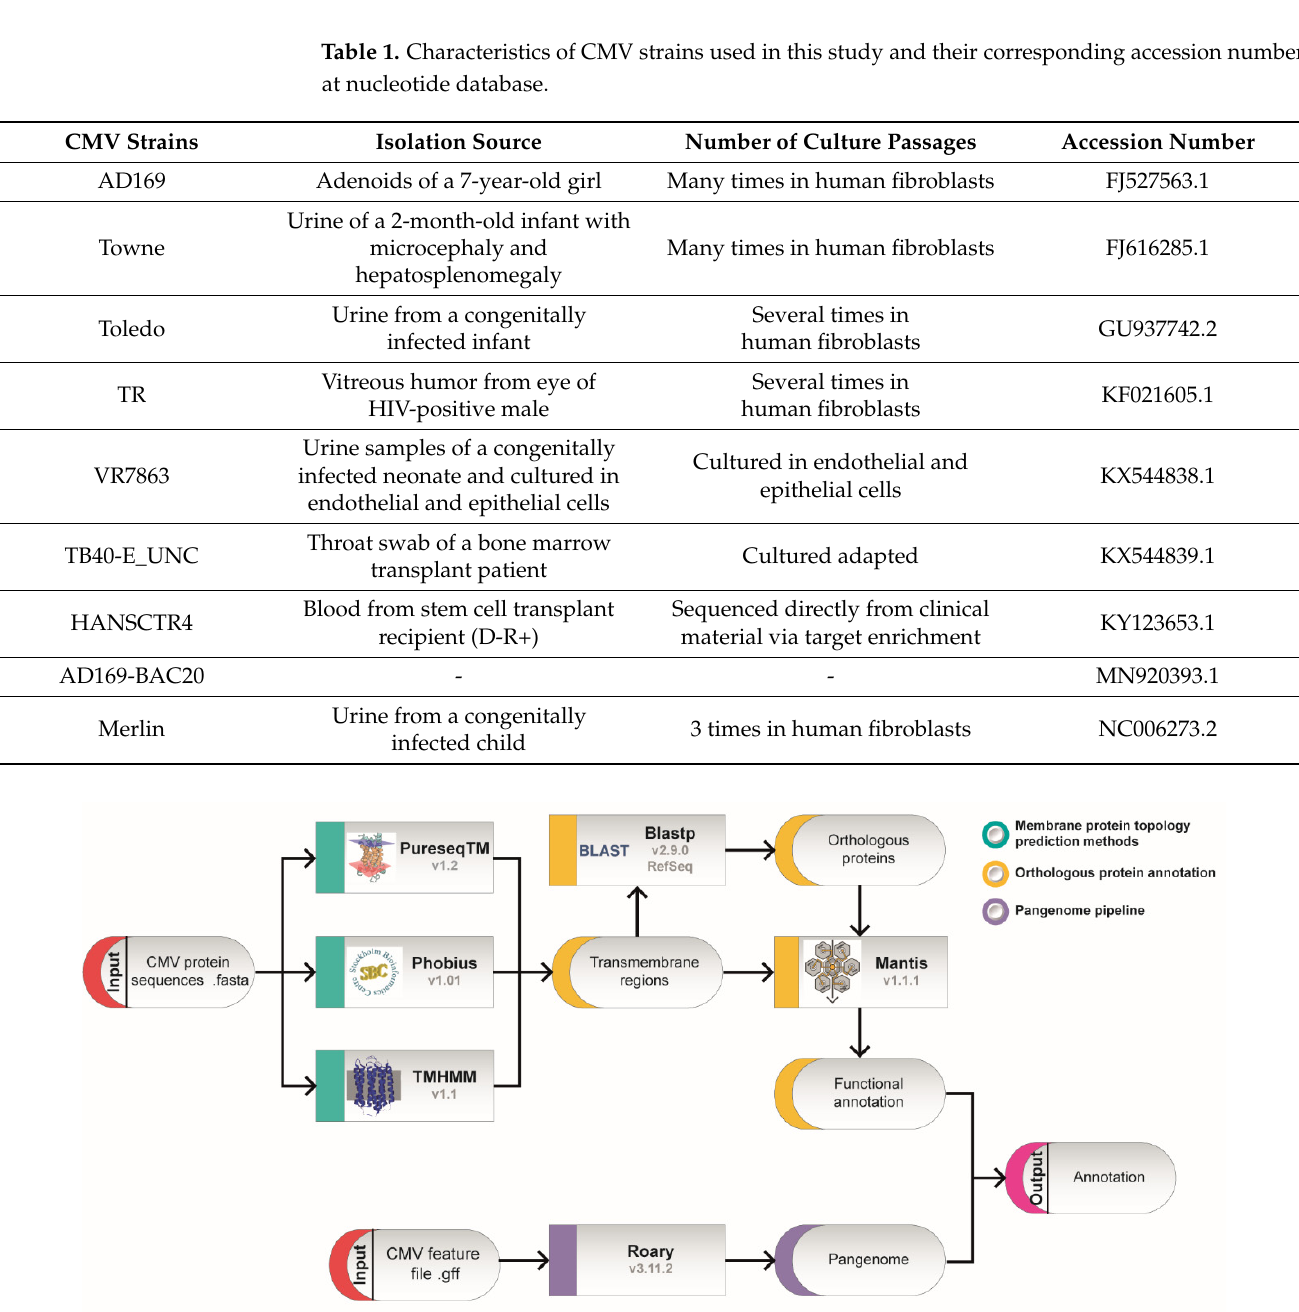
Figure 1. Schematic representation of the applied workflow. Fasta format protein sequences from nine CMV genomes were analyzed in parallel to predict transmembrane domains and to create an entire set of genes from all strains (pangenome). Transmembrane topology was studied following three different approaches: PureseqTM, Phobius and TMHMM, under default parameters. Predicted transmembrane proteins were compared with orthologous proteins identified by BLAST with the whole Mantis database for the prediction of functional annotation. Proteins that were common to all nine genome datasets formed the core protein set, and functions were annotated accordingly for each transmembrane protein.